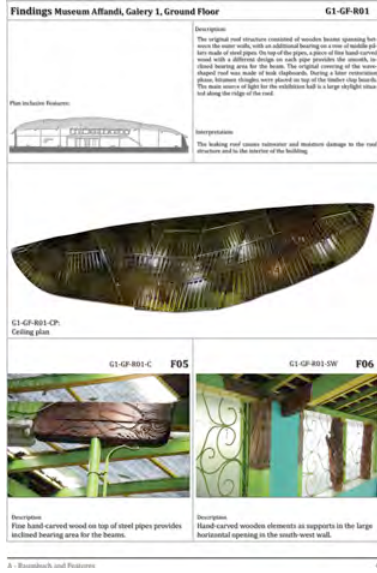
Figure 4: Room book extract of gallery 1 (G. Styhler-Aydin